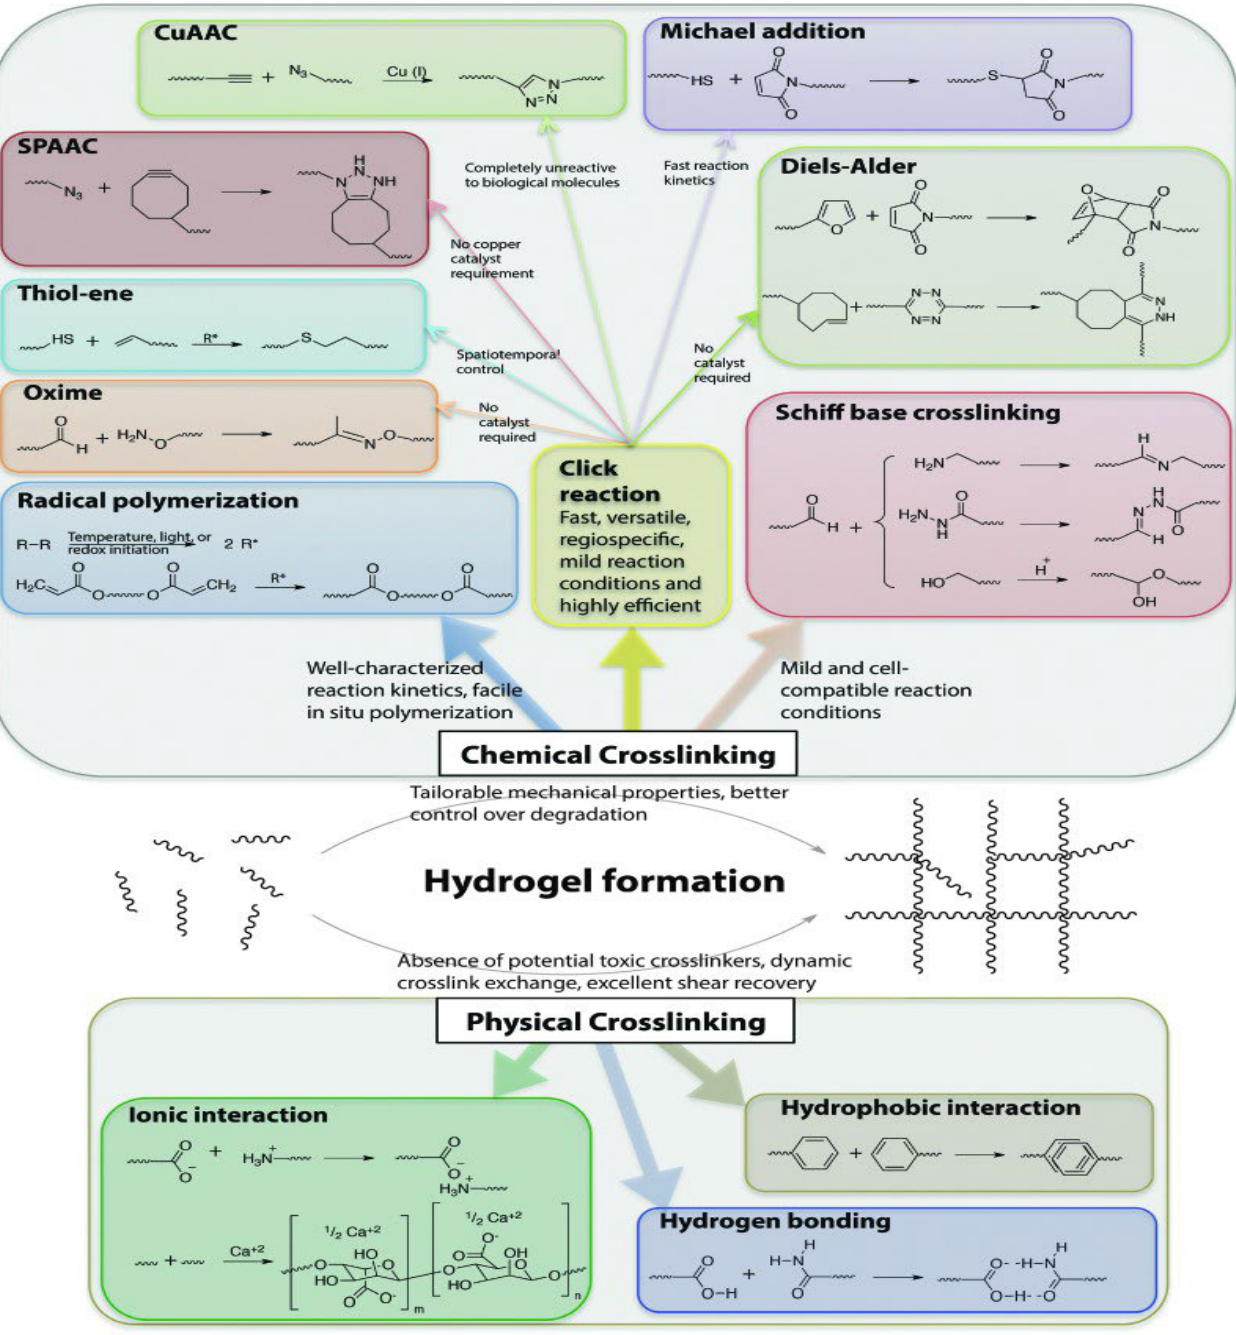
Figure 7. The various mechanisms of cross-linking that result in gelation [Obtained and reproduced without any changes from [87] and The Royal Society of Chemistry in accordance with Creative Commons Attribution License (CC BY)].